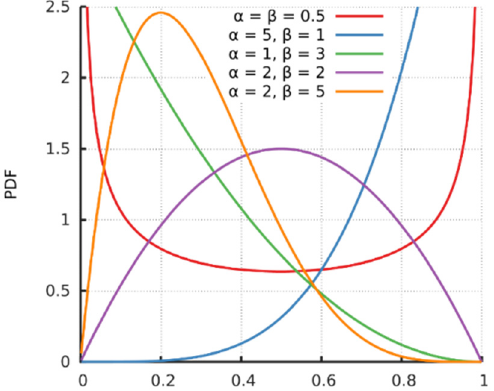
Figure 5. Probability density function (PDF) of the Beta function [31].